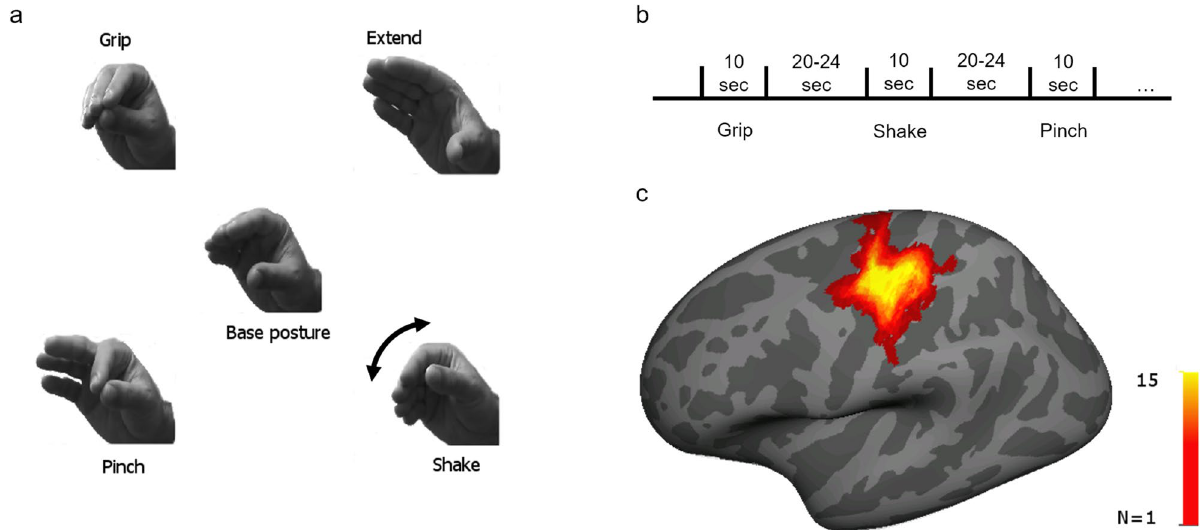
Figure 1. (a) The four different hand movements used in the study. Center—base hand posture for all movements. In each condition participants were asked to repeatedly and smoothly alternate between the base hand posture and one of the other four positions, creating the different hand movements. Top left—Grip movement, closing hand; top right—Extend movement, opening hand; bottom left—Pinch movement, closing only two fingers; bottom right—Shake movement, rotation of the wrist. Grip, Extend and Pinch were coded as ecological hand movements. Shake movement was chosen as the control movement. (b) experimental design— participants completed five task runs (except for one participant who completed seven runs, and another who completed only four), and each run included twelve motor blocks (three of each movement) of 10 s continuous hand movement. Task blocks were separated by rest blocks (20–24 s long). (c) Motor ROI—for each participant we identified a motor cortex region of interest (ROI) in which the BOLD activation for all the motor tasks was significantly higher than baseline activity. ROIs were identified on the native cortical surface of each participant. For presentation purposes only all ROIs were projected on an average surface (Freesurfer fsaverage) and summed together. The color scale represents the number of participants for which the specific vertex on the surface was included in the ROI. Talairach coordinates of the center of mass of the summed ROIs [− 36, − 23,